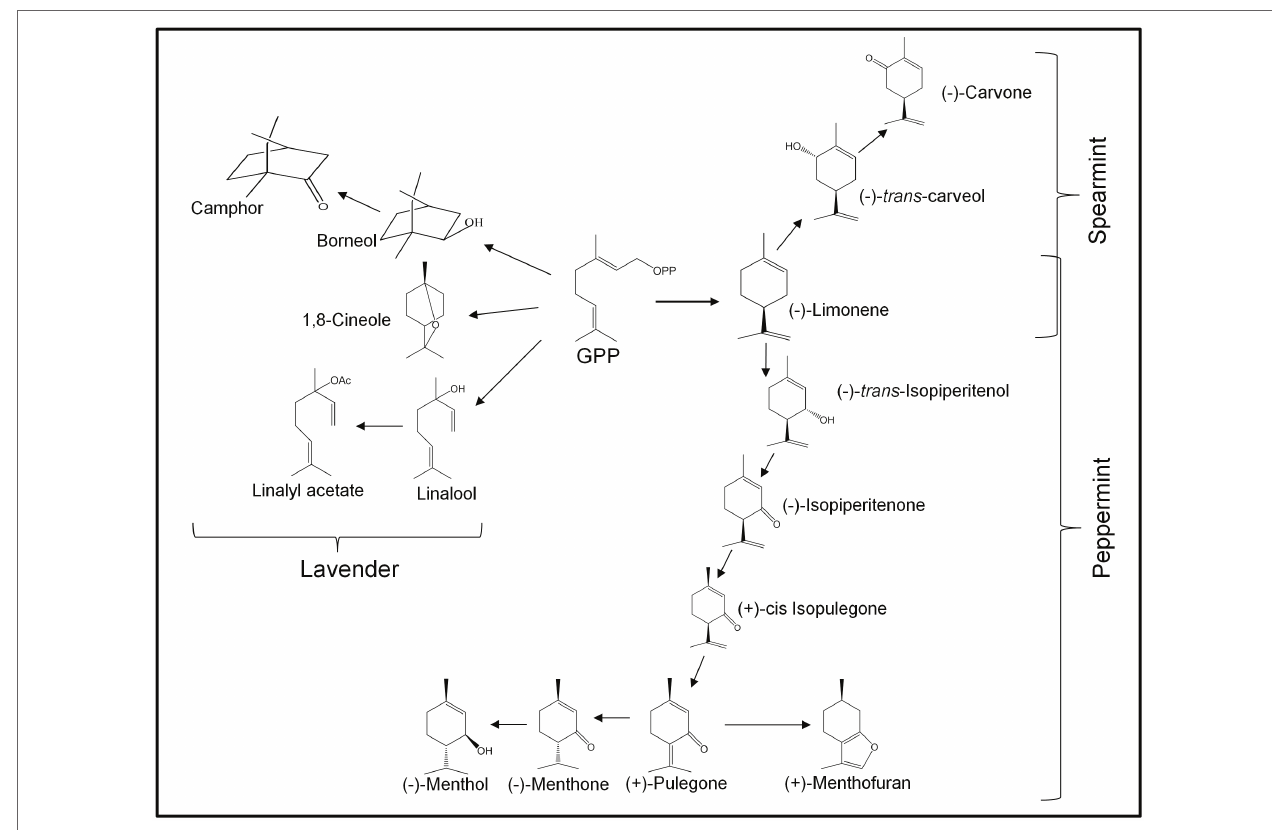
FIGURE 3 | The biosynthetic pathways for monoterpene metabolism in lavender, peppermint, and spearmint. Representative monoterpenes derived from GPP are shown, and the corresponding enzymes involved in the process are previously reported for each species (Croteau et al., 2005; Ringer et al., 2005; Landmann et al., 2007; Demissie et al., 2012; Adal et al.,